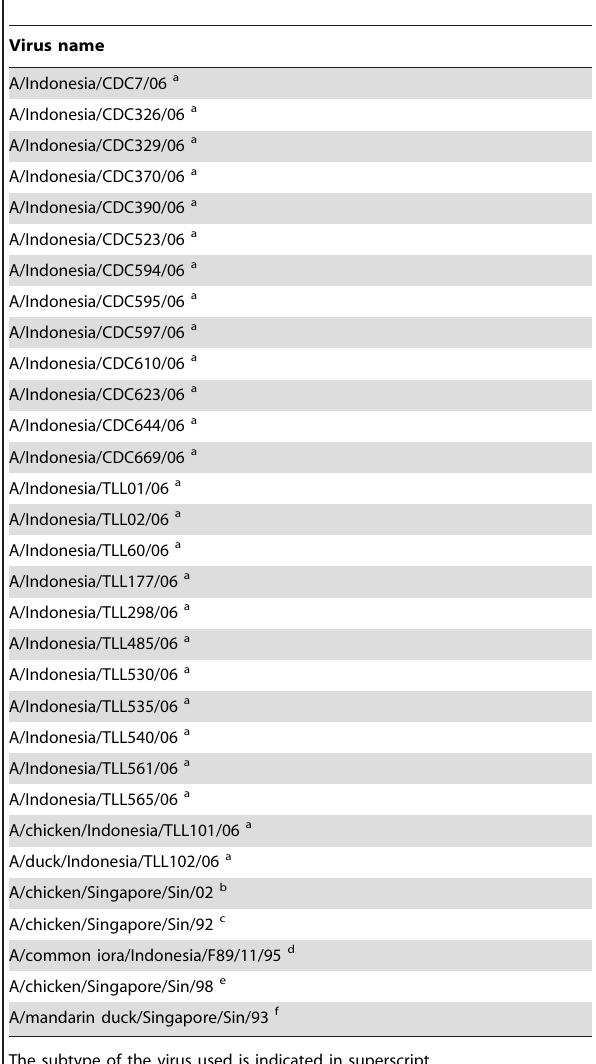
Table 1. Avian influenza viruses used in this